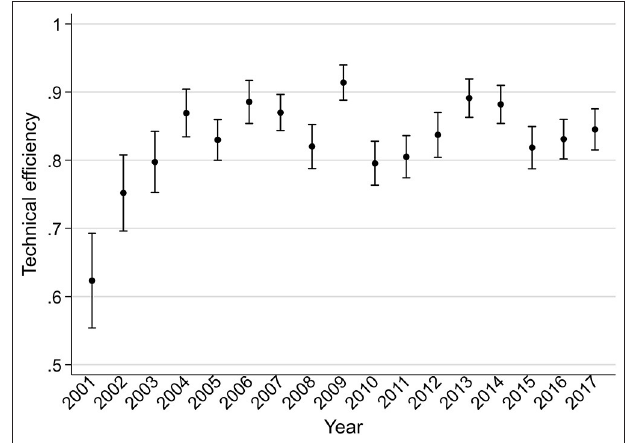
FIGURE 1 | Technical efficiency of 47 prefectures from 2001 to 2017 based on the translog production function. The means of technical efficiency are indicated by point symbols and 95% confidence intervals are indicated by capped